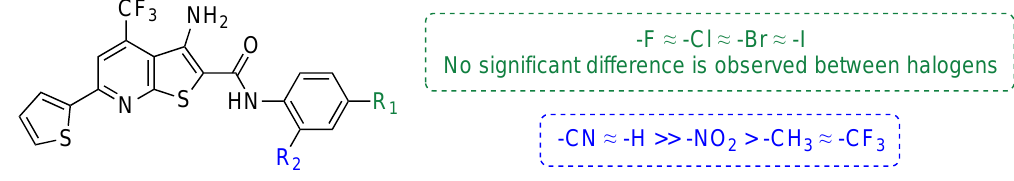
Figure 5. Summary of structure – activity relationship.